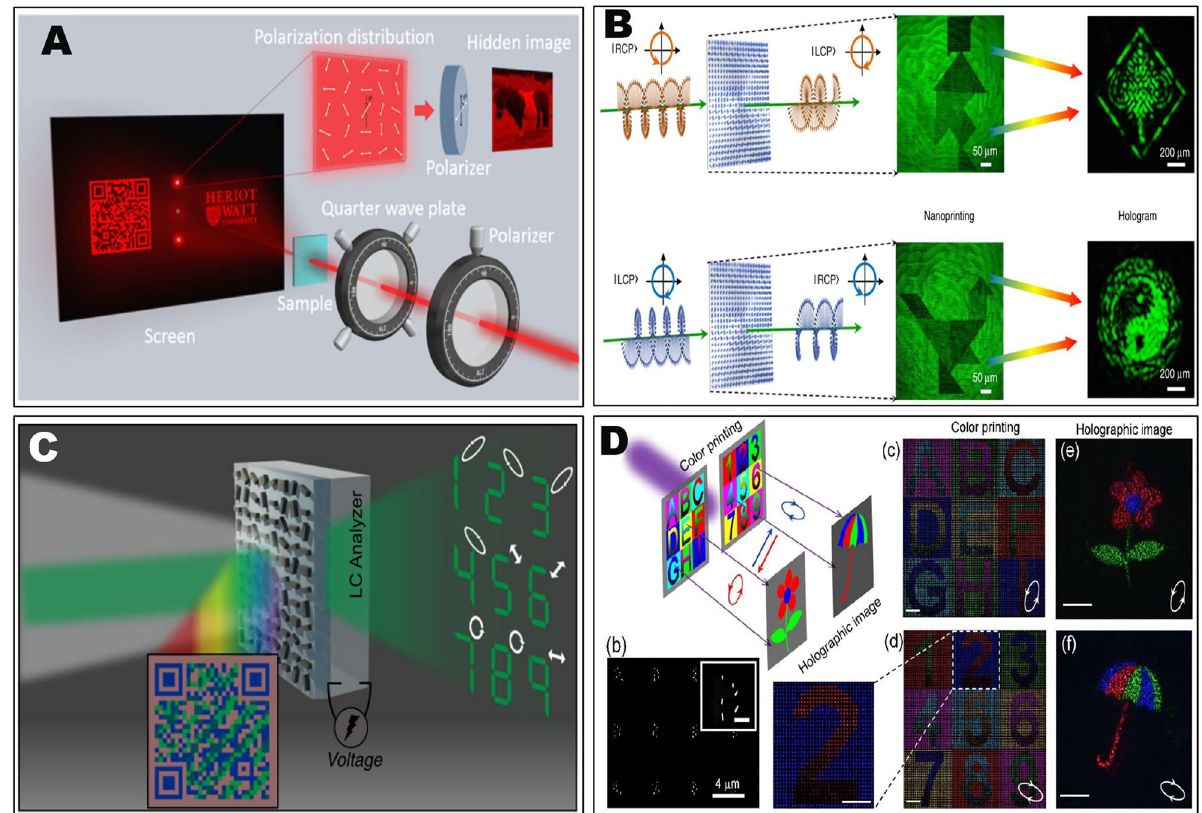
Figure 4: The combination of near-field image encoding and far-field vectorial holography. (A) The multichannel metadevice that combines holographic images and a grayscale image nanoprint for anticounterfeiting and encryption [134]. (B) A four-channel TiO 2 metasurface device that generates grayscale nanoprinting-hologram images under the illumination of RCP and LCP, respectively, in the near fi eld and far fi eld [135]. (C) A bi-functional metasurface that combines structural color printing and vectorial holography [136]. (D) A silicon metasurface realizes two independent full-color printed images and vectorial holograms